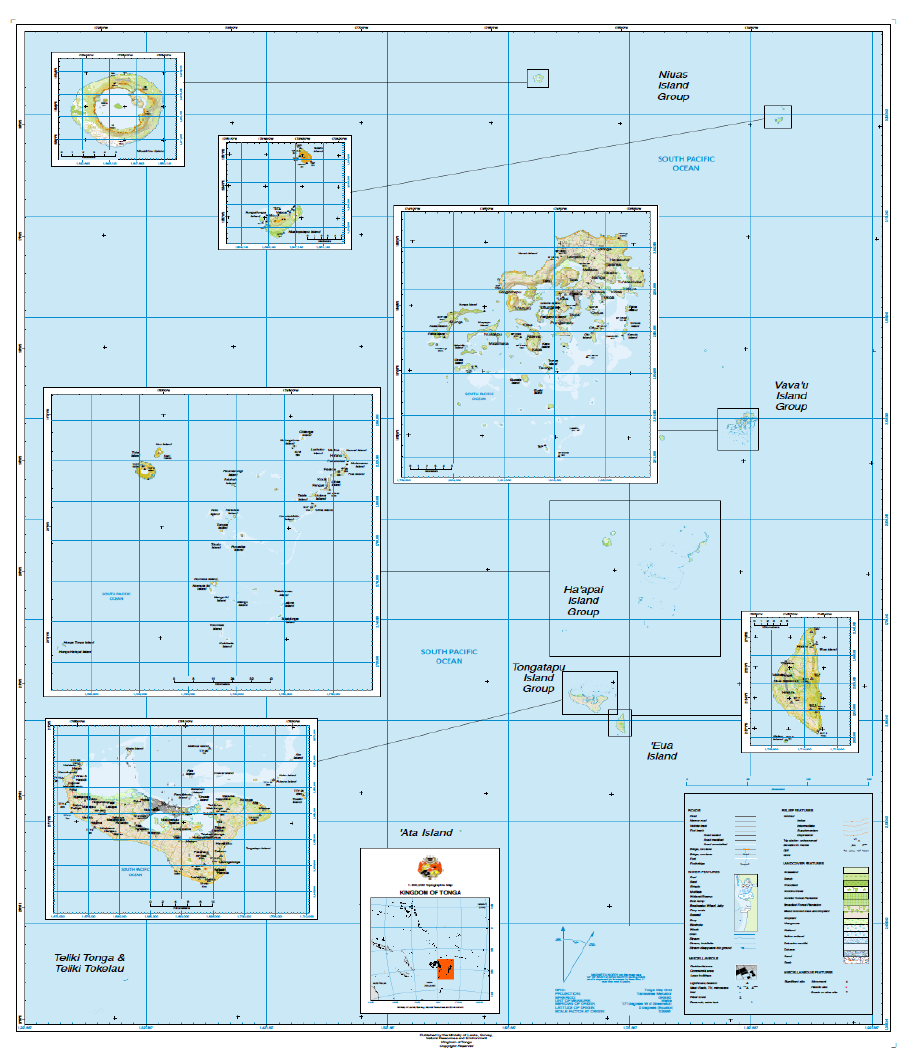
Figure 1. Map of the Kingdom of Tonga. Image courtesy of the Ministry of Lands, Survey and Natural Resources, Tonga.